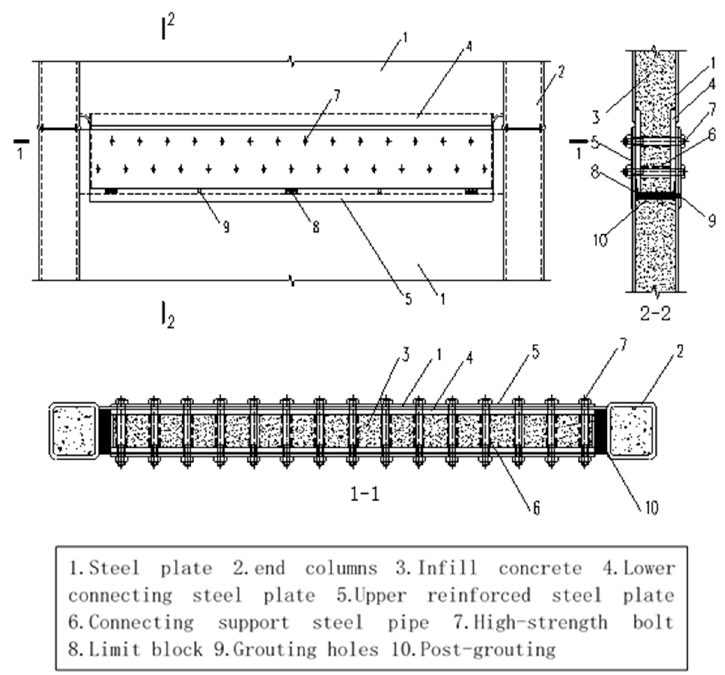
Figure 1. The constitution diagram of composite shear wall.